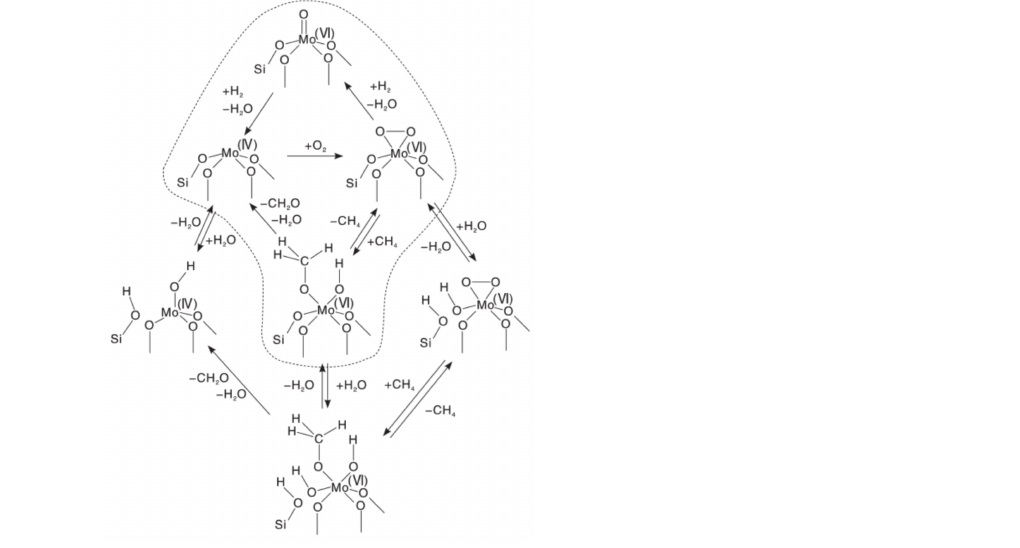
Figure 4. The mechanism of CH 4 oxidation at isolated, SiO 2 -supported MoO x sites, including parallel pathways enabled by the presence of H 2 O [43]. Copyright 2006, with permission from American Chemical Society.